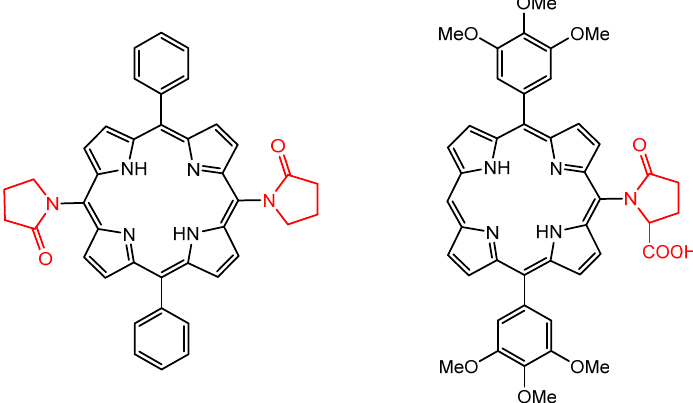
Figure 3. Structures of antiparasitic free-base porphyrin derivatives containing pyrrolidinone moieties, proposed by Abada et al. [51].